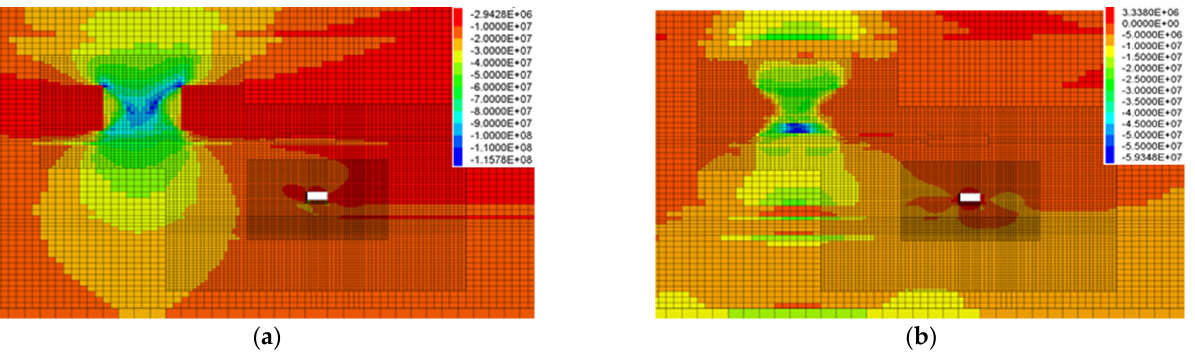
Figure 15. Principal stress distribution contour of the roadway’s surrounding rock when the coal column is 4 m. ( a ) σ 1 cloud. ( b ) σ 3